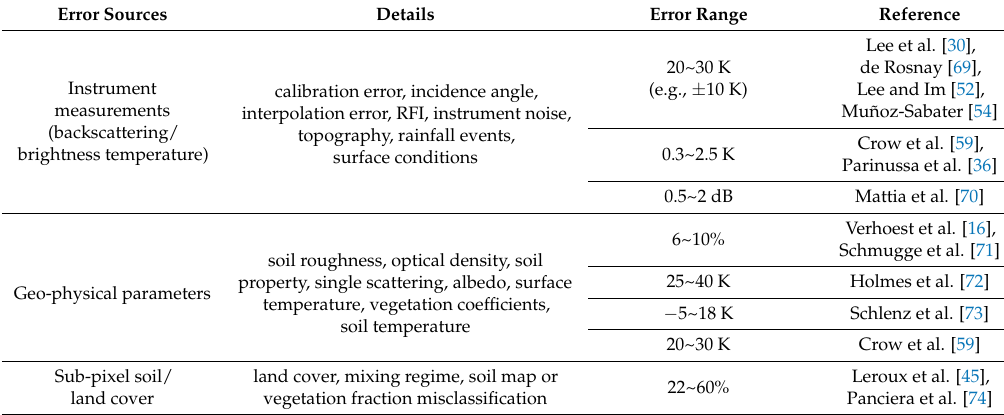
Table 1. Error sources to consider for ensemble